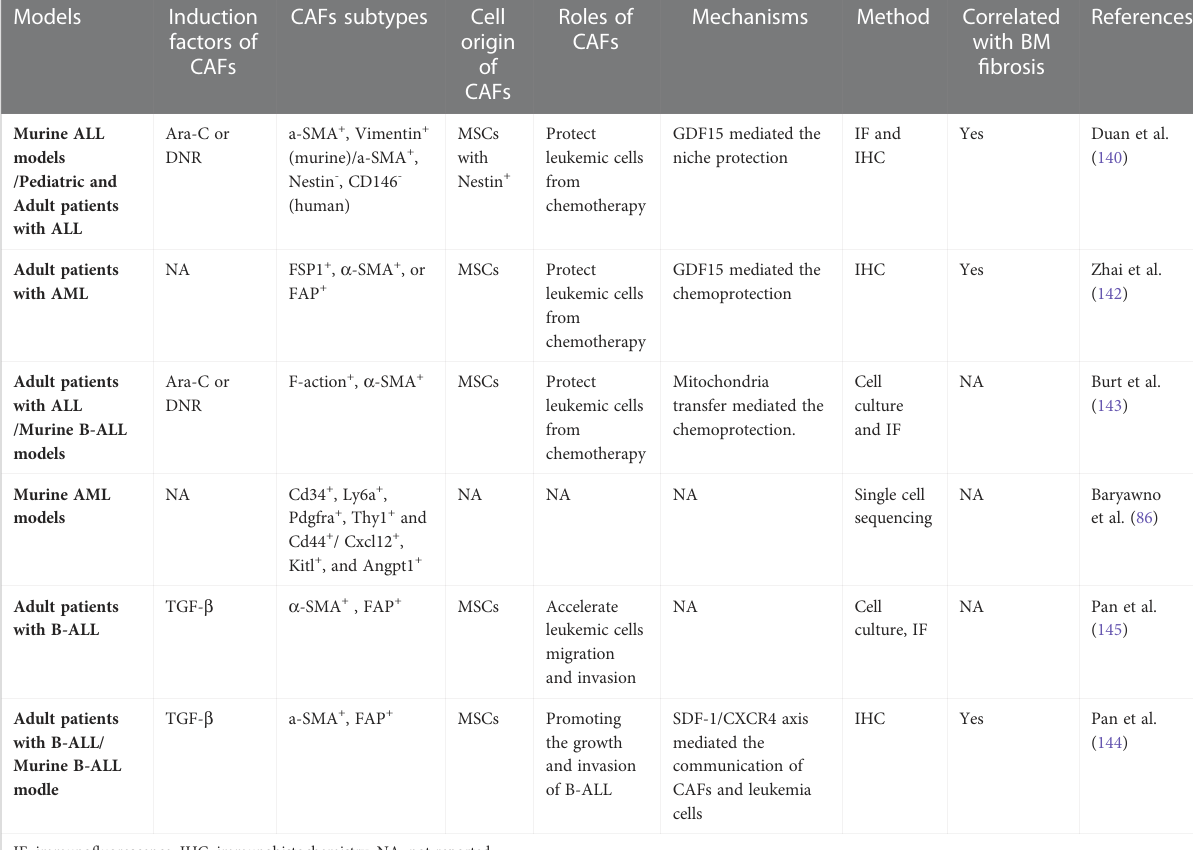
TABLE 1 CAFs in AL and their functions in leukemia